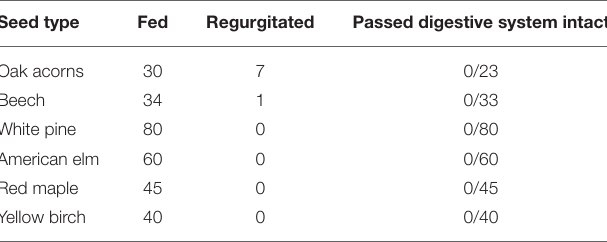
TABLE 1 | Gastrointestinal seed passage results for band-tailed